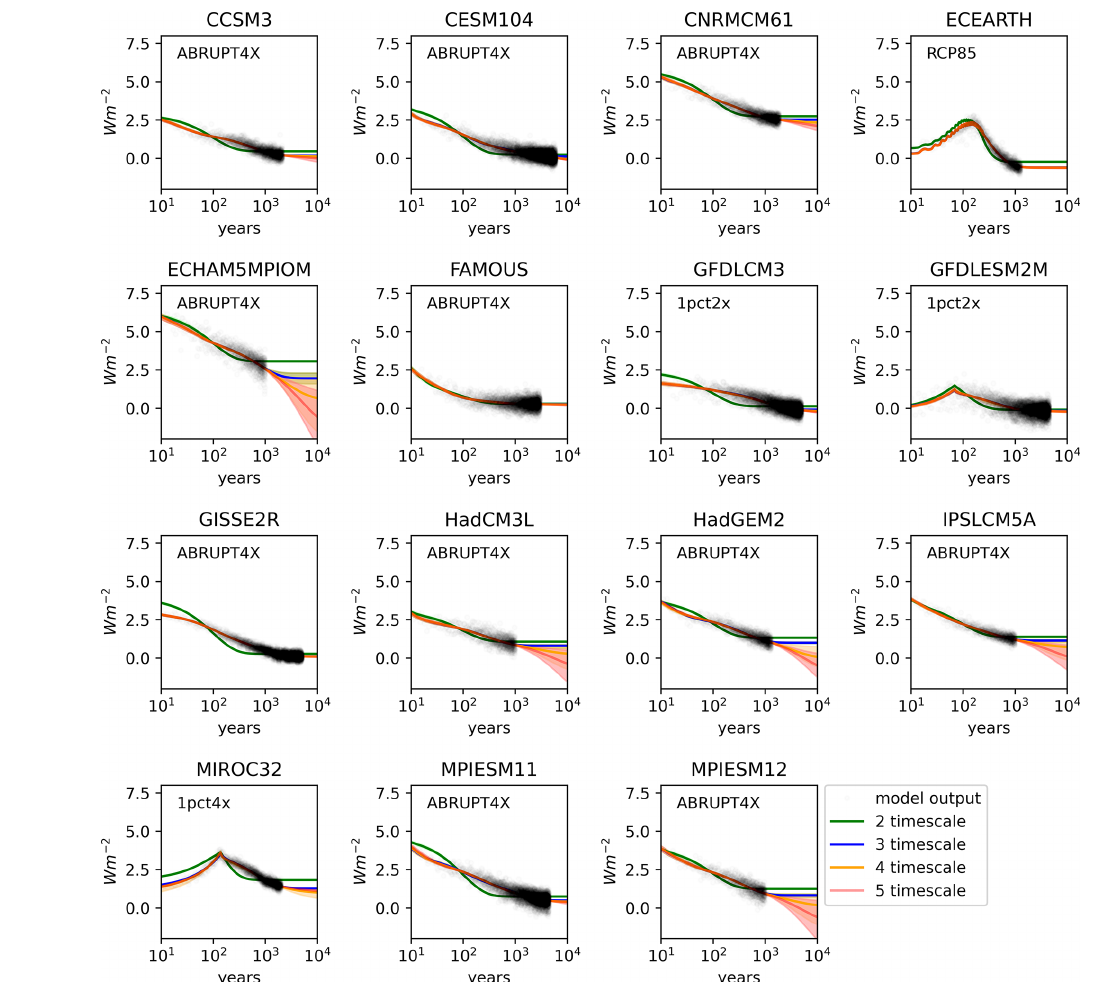
Figure A2. Results fitting multi-timescale models to output of LongRunMIP multi-thousand-year experiments for global top-of-atmosphere radiative imbalance. Different colors represent different models as detailed in Table 1; shaded areas indicate the 5th–95th percentile range in the MCMC fit to the time series. Text indicates the model scenario used in the fit (as detailed in Table 3).